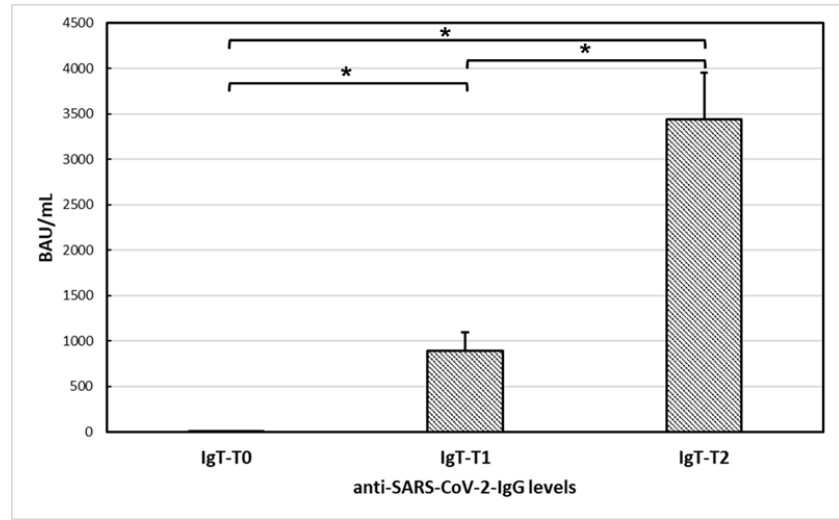
Figure 2. Anti-SARS-CoV-2-IgG levels at T0, T1, and T2 in controls with C1-esterase inhibitor deficiency hereditary angioedema ( n = 29). ANOVA conducted on anti-SARS-CoV-2-IgG levels revealed a significant difference (*) among the determinations at T0, T1, and T2 [F(1,27) = 39.21; p < 0.001]. Post-hoc comparisons revealed significantly higher levels of anti-SARS-CoV-2-IgG levels at T1 (post-hoc p < 0.05) and T2 (post-hoc p < 0.001) compared to T0, and at T2 and compared to T1 (post-hoc p < 0.05).